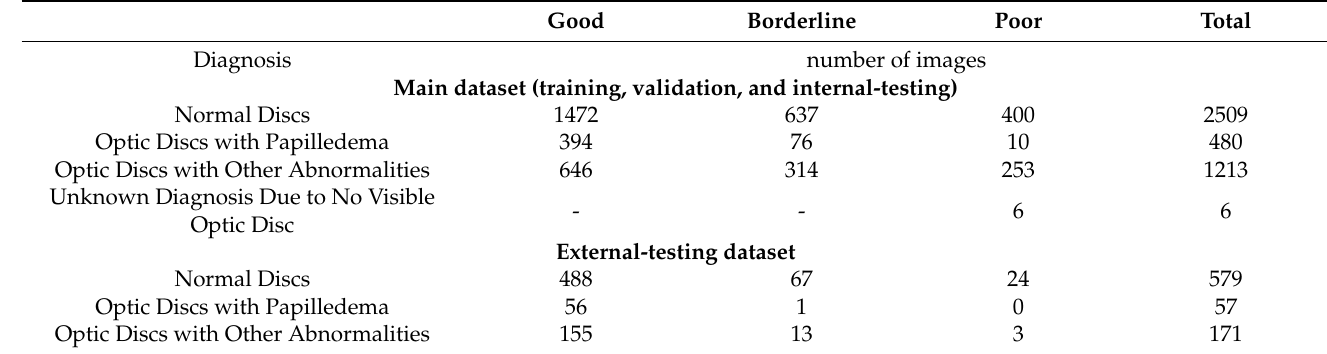
Table 1. Summary of Training, Validation, Internal-Testing and External-Testing Data Sets, According to Diagnosis of Fundus Images. Good